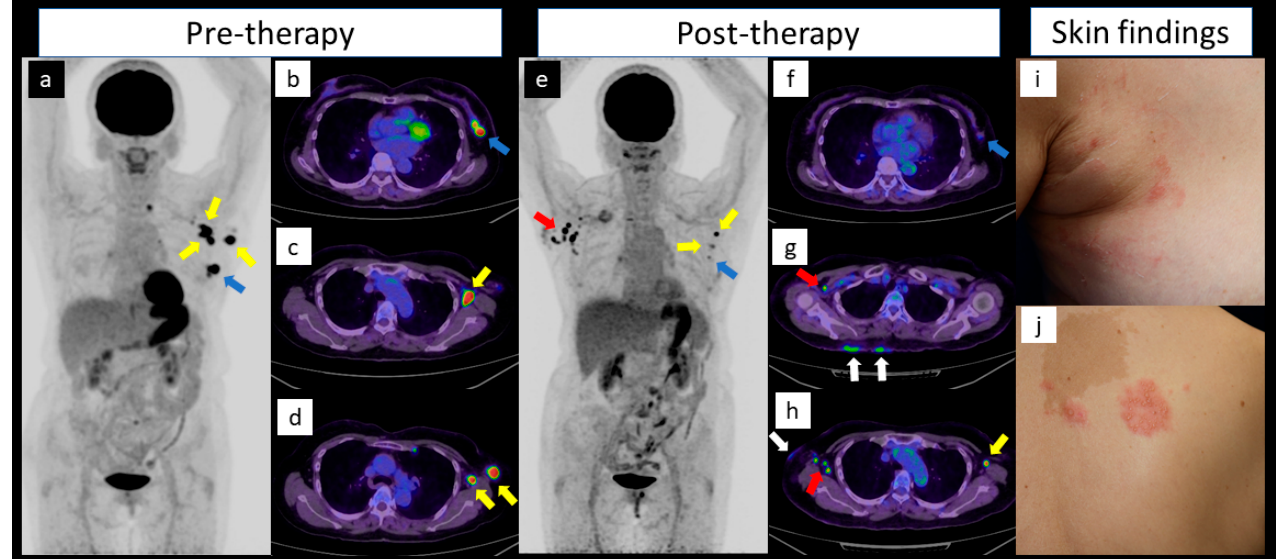
Figure 1. ( a ) Maximum-intensity projection (MIP) and ( b – d ) transaxial 18F-Fluorodeoxyglucose positron-emission tomogra- phy/computed tomography (18F-FDG PET/CT) images before therapy revealed ( a , b : blue arrows) intense, hot uptake in the left breast mass indicating cancer, and ( a , c , d : yellow arrows) left axillary lymph nodes indicating metastasis. ( a ) No other areas of uptake indicated distant metastasis. ( e ) MIP and ( f – h ) transaxial images of 18F-FDG PET/CT after therapy showed shrinking and decreased uptake in the ( e , f : blue arrows) cancerous mass and ( e , h : yellow arrows) left axillary lymph node metastasis, whereas ( e , g , h : red arrows) enlarged lymph nodes with high FDG uptake appeared in the right axilla. ( g , h : white arrows) Thickening of the skin on the right upper hemithorax with mild FDG uptake was also observed. The patient had painful vesicular eruption on the ( i ) front to ( j ) back of the right upper hemithorax, which was diagnosed as active herpes